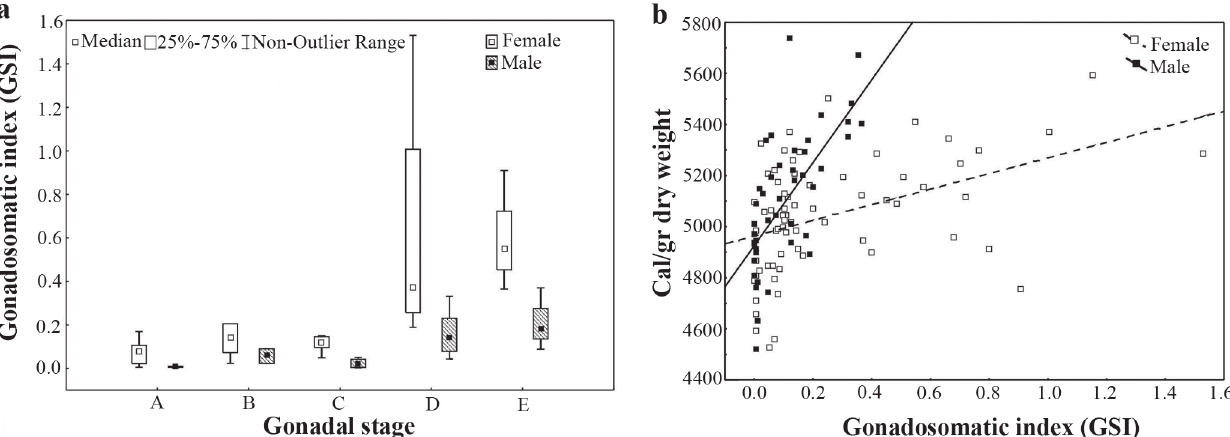
Fig. 4. ( a ) Gonadosomatic index (GSI), mean values of the gonadosomatic index, per gonadal maturation stage; ( b ) Correlation between caloric content and gonadosomatic index. Gonadal maturation stages: A = immature, B = resting, C = maturing, D = mature, E = spent.